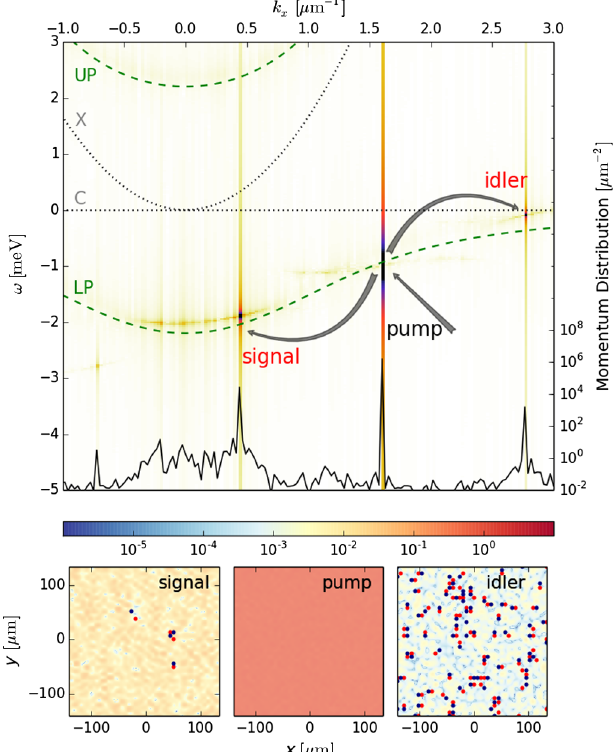
FIG. 1. Polariton system in the OPO regime. Upper panel: 2D ω Þj 2 (logarithmic map of the photonic OPO spectrum j ψ C;k x ;k y ¼ 0 ð scale) of energy ω versus the k momentum component (cut at x 0 ) for a single noise realization and at a pump power k y ¼ 1 . 024 36 f th f , where f th is the mean-field OPO threshold. p ¼ p p The arrows show schematically the parametric process scattering polaritons from the pump state into the signal and idler modes. Dashed (green) lines show the bare upper polariton (UP) and lower polariton (LP) dispersions, while dotted (black) lines are the cavity photon ( C ) and exciton ( X ) dispersions. The solid 0 cut of the (black) line underneath the spectrum is the k y ¼ single-shot time-averaged in the steady state momentum distri- R dt j ψ t Þj 2 , clearly showing the macroscopic bution C;k x ;k y ¼ 0 ð occupation of the three OPO pump, signal, and idler states. r ; t Þj 2 Lower panels: 2D maps of the filtered space profiles j ψ s;p;i ð at a fixed time t for which a steady state regime is reached — the pump emission intensity is rescaled to 1. Blue (red) dots indicate the vortex (antivortex) core